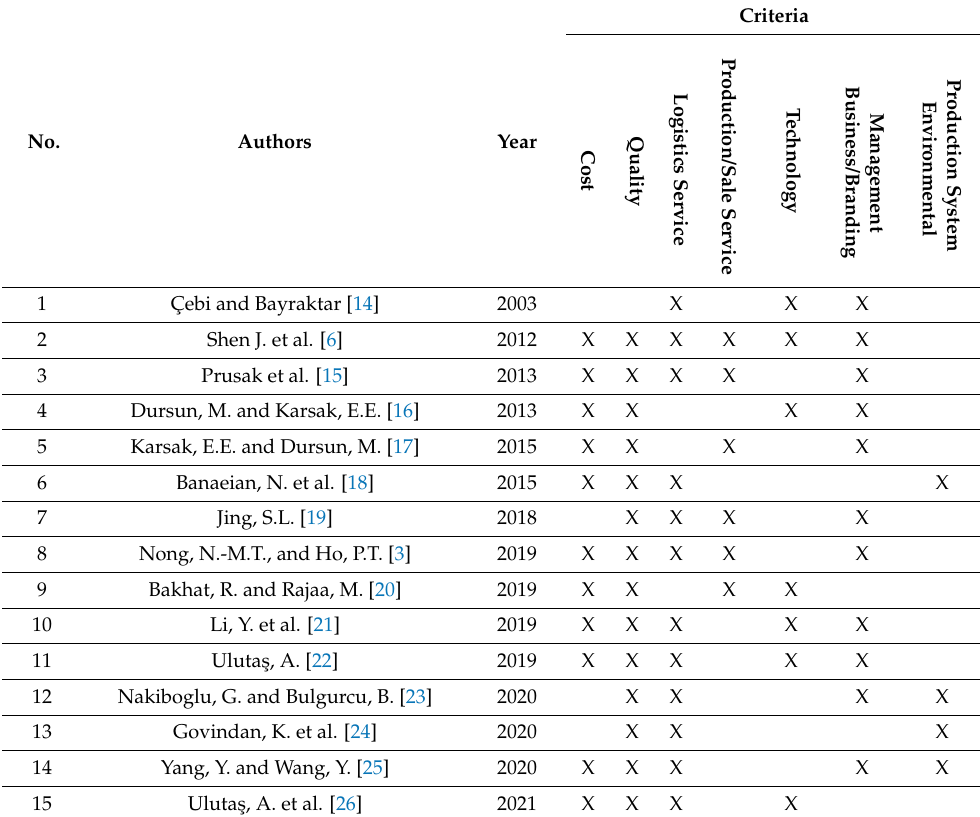
Table 1. A&TOMs selection criteria.